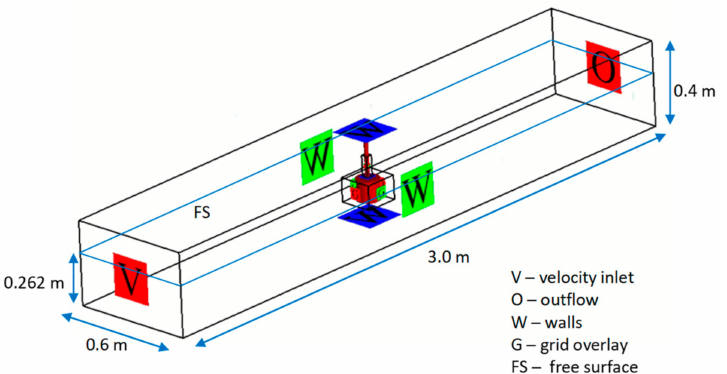
Figure 7. Boundary conditions for rotor-generated flow field simulation—computing domain with free surface